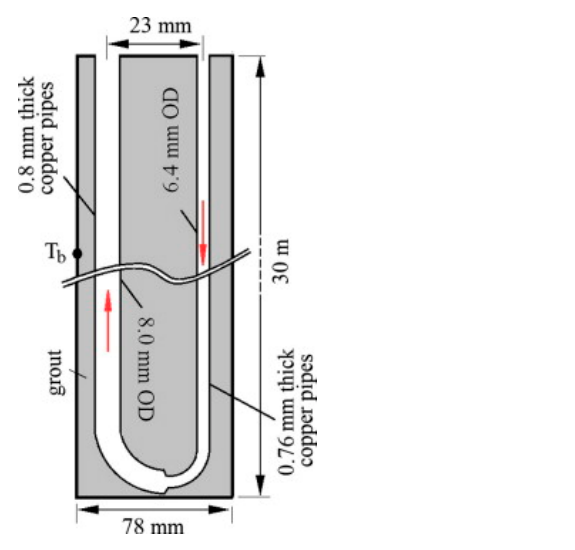
Figure 6. Schematic presentation of a vertical geothermal borehole. Reproduced with permission from [120]. Elsevier, 2014.